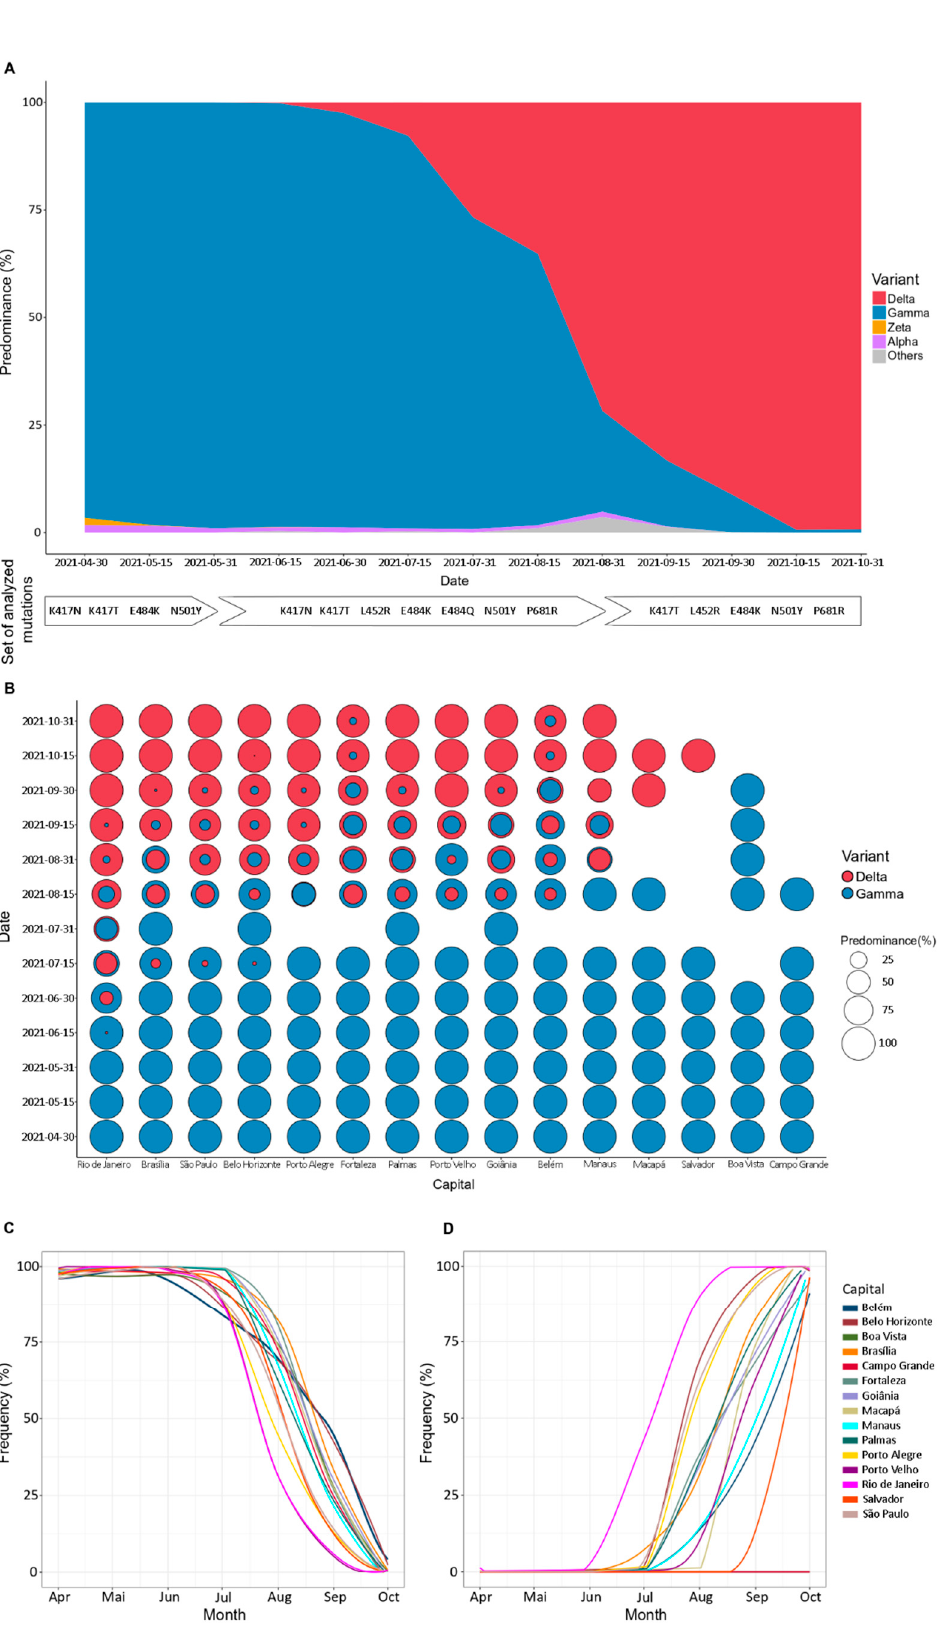
Figure 2. Most prevalent severe acute respiratory syndrome coronavirus 2 (SARS-CoV-2) variants detected in Brazil by genotyping analysis. ( A ) Gamma (blue) and Delta (red) were the main variants detected in the period evaluated. In the first months of monitoring, Gamma was predominant but gradually replaced by Delta. Other variants, such as Alpha (purple) and Zeta (yellow), were also